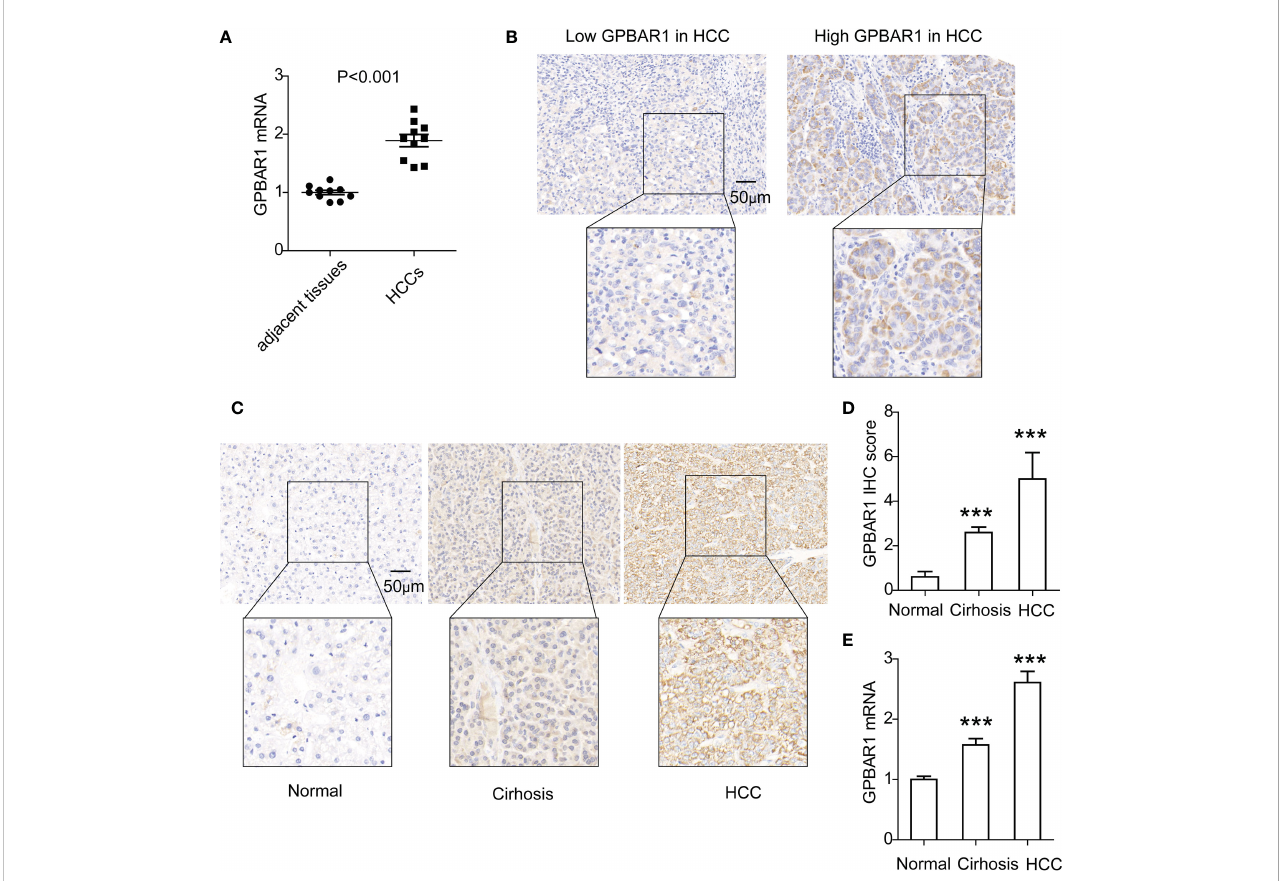
FIGURE 1 Expression of GPBAR1 in HCC and adjacent tissues. (A) The mRNA level of GPBAR1 was assessed by qPCR in 10 pairs of HCC and tumor-adjacent tissues. The statistical signi fi cance is analyzed by a paired t -test. (B) GPBAR1 expression in HCC was detected by IHC, which divided the cohort into GPBAR1 low and GPBAR1 high subsets. (C, D) GPBAR1 expressions in normal liver tissues, liver cirrhosis, and HCC tissues were detected with IHC (C) . The IHC scores of GPBAR1 in these tissues were evaluated and compared (D) . (E) GPBAR1 expressions in normal liver tissues, liver cirrhosis, and HCC tissues were detected with qRT-PCR. The average level of GPBAR1 mRNA in normal liver tissues was set as a baseline for data normalization. *** p < 0.001 with a one-way ANOVA. The data were from at least three independent